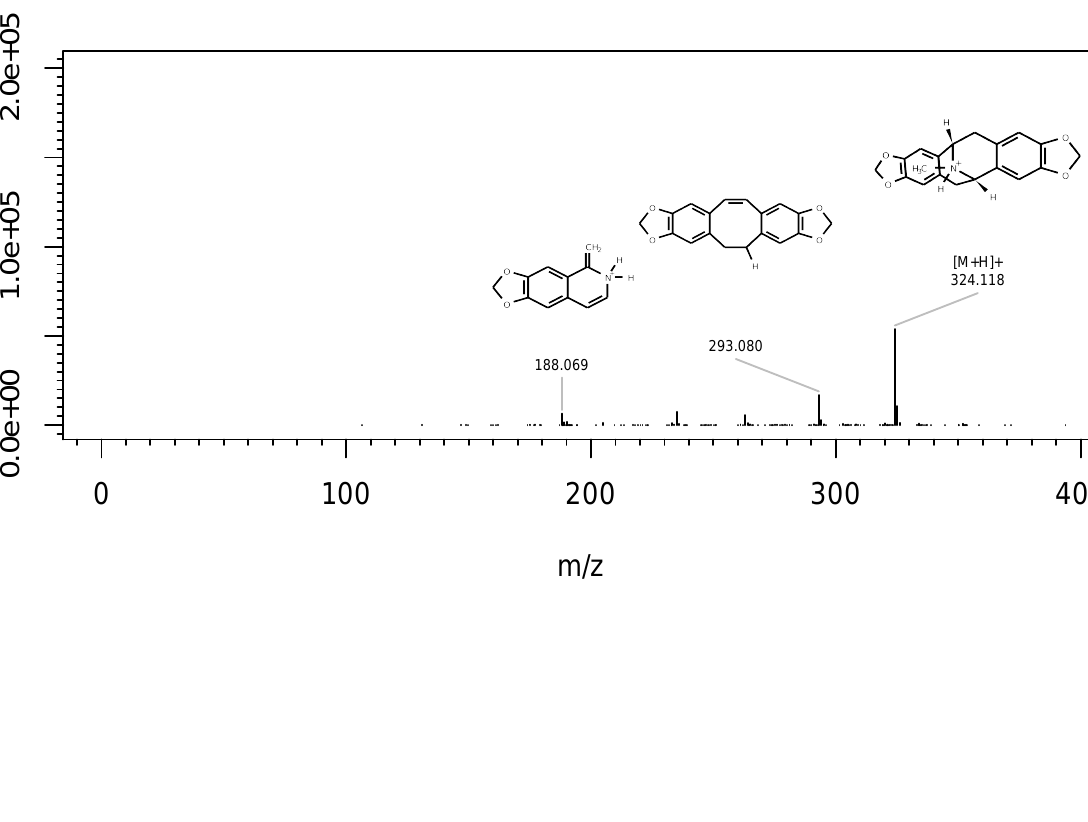
Figure A4. Challenge 4: annotated merged MS/MS spectra of escholtzine (ESI, positive